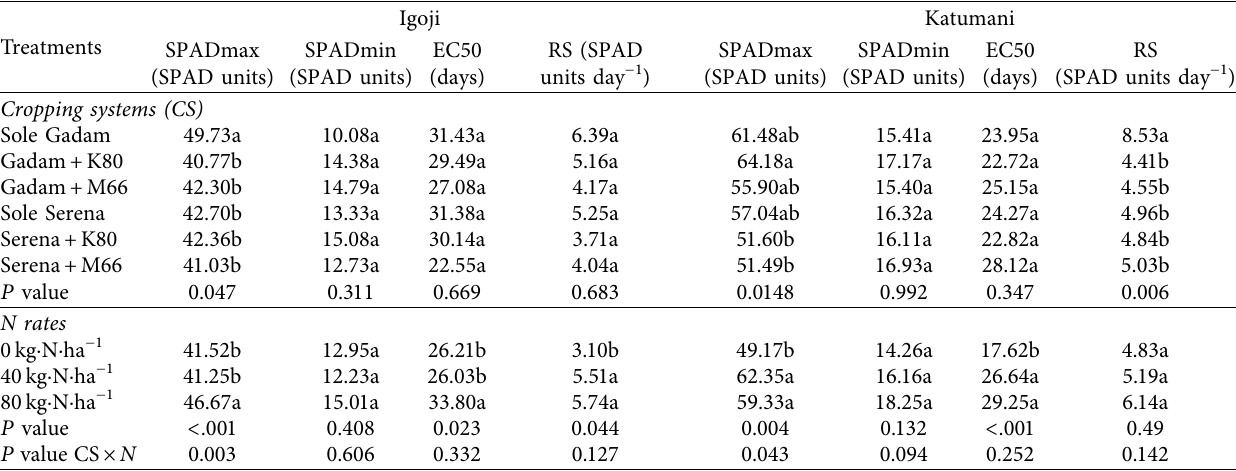
Table 5: Maximum leaf greenness (SPADmax), minimum leaf greenness (SPADmin), time to loss of 50% SPADmax (EC50), and the rate of leaf senescence (RS) means of two sorghum varieties (Gadam and Serena) grown in sole and intercrop system with two varieties of cowpea (K80 and M66) and N rate at the KALRO research stations in Igoji and Katumani during 2018/2019 short rains season. Igoji Treatments Cropping systems